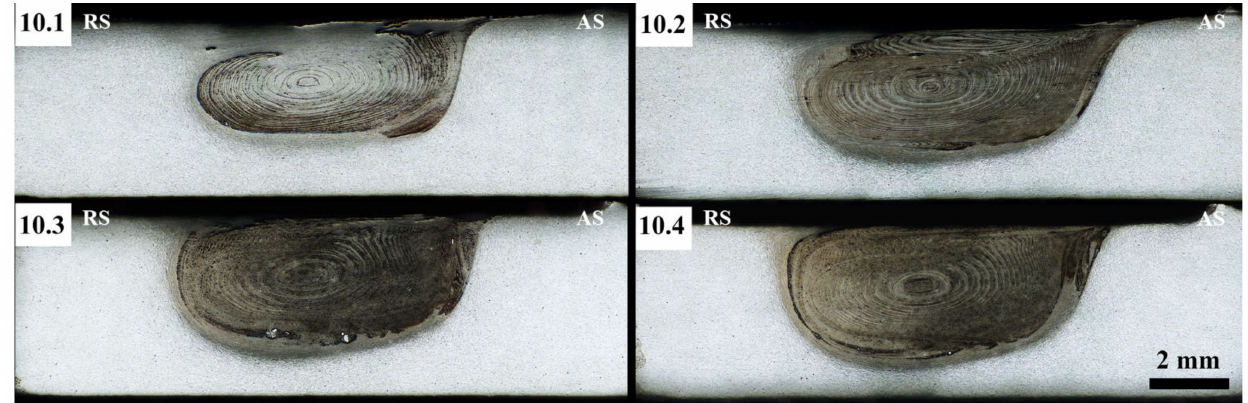
Figure 4. Al-Mg-Sc alloy macrostructure after FSP with 10 wt% Mo after 1–4 passes (samples 10.1–10.4). AS—advancing side, RS—retreating